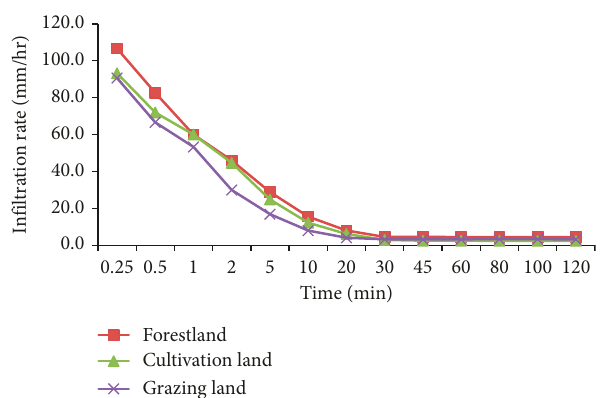
Figure 3: Infiltration rate curves for land use types, Geshy